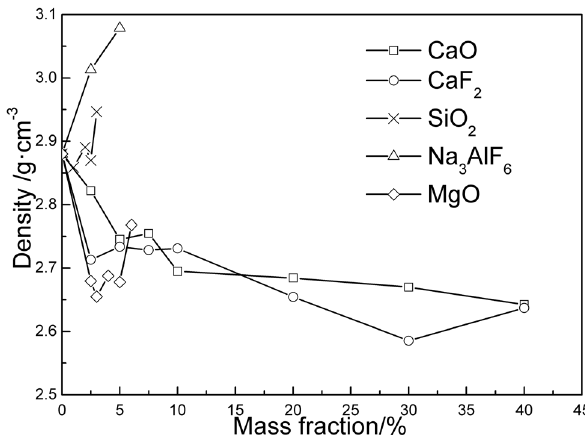
Figure 6: E ff ect of di ff erent additives on the density of slags at 1,923 K ( 1,650°C ) .